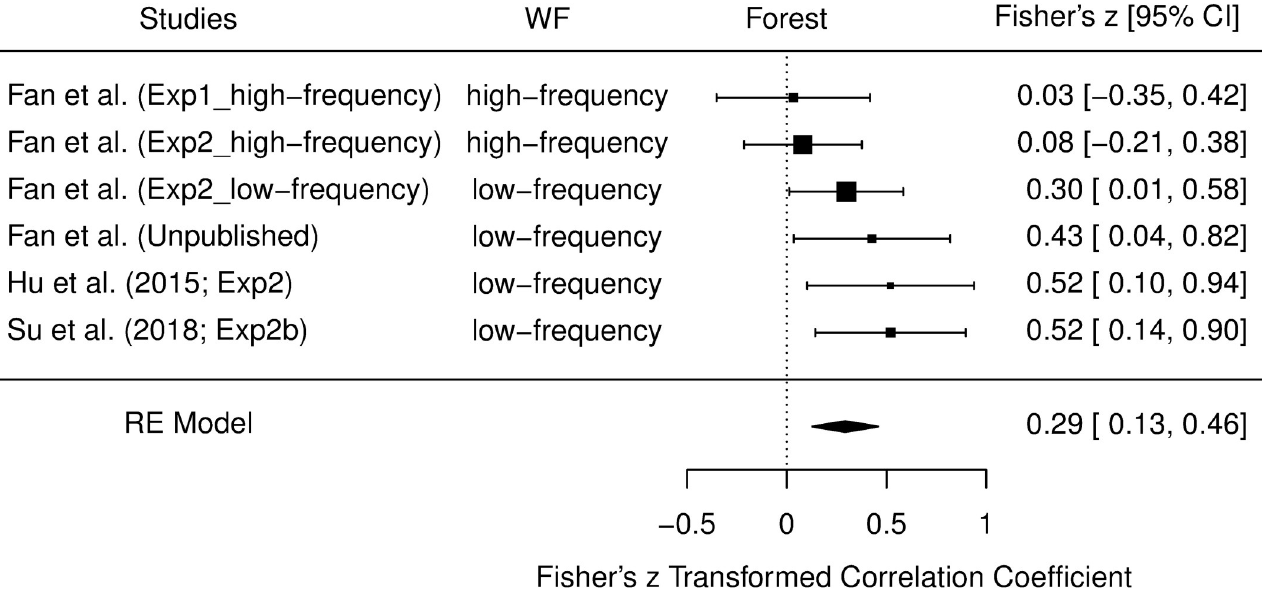
Fig 5. Forest plot depicting the meta-analytic summary of the correlation between beliefs about font size and the font size effect on JOLs. Each raw depicts a single experiment with its WF condition. The estimated effect sizes along with their 95% confidence intervals (CIs) are also shown. The black diamond at the bottom of the plot represents the overall effect size (Fisher’s z ), estimated using a random-effects model. The horizontal end-points of the diamond correspond to the upper and lower limits of 95% CI.